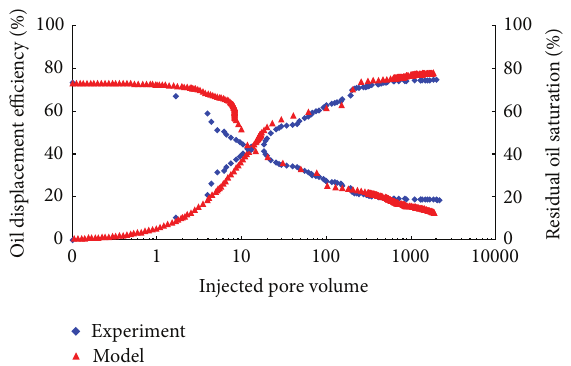
Figure 8: Oil displacement efficiency, residual oil saturation from experiment, and model during long-term water flooding.